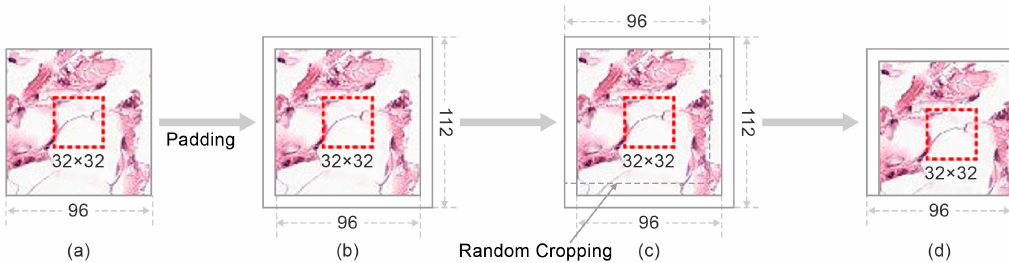
Figure 4. The workflow of the Random Center Cropping (RCC). ( a ) is the original training image. Images are first padded with eight pixels from four directions ( left , right , up , down ) to create a 112 × 112 resolution as shown in ( b ). ( c ) demonstrates the process that Random cropping is then performed on these modified images to restore a 96 × 96 resolution image ( d ). Particular center areas are shown in the red dashed rectangular and retained after the cropping process.